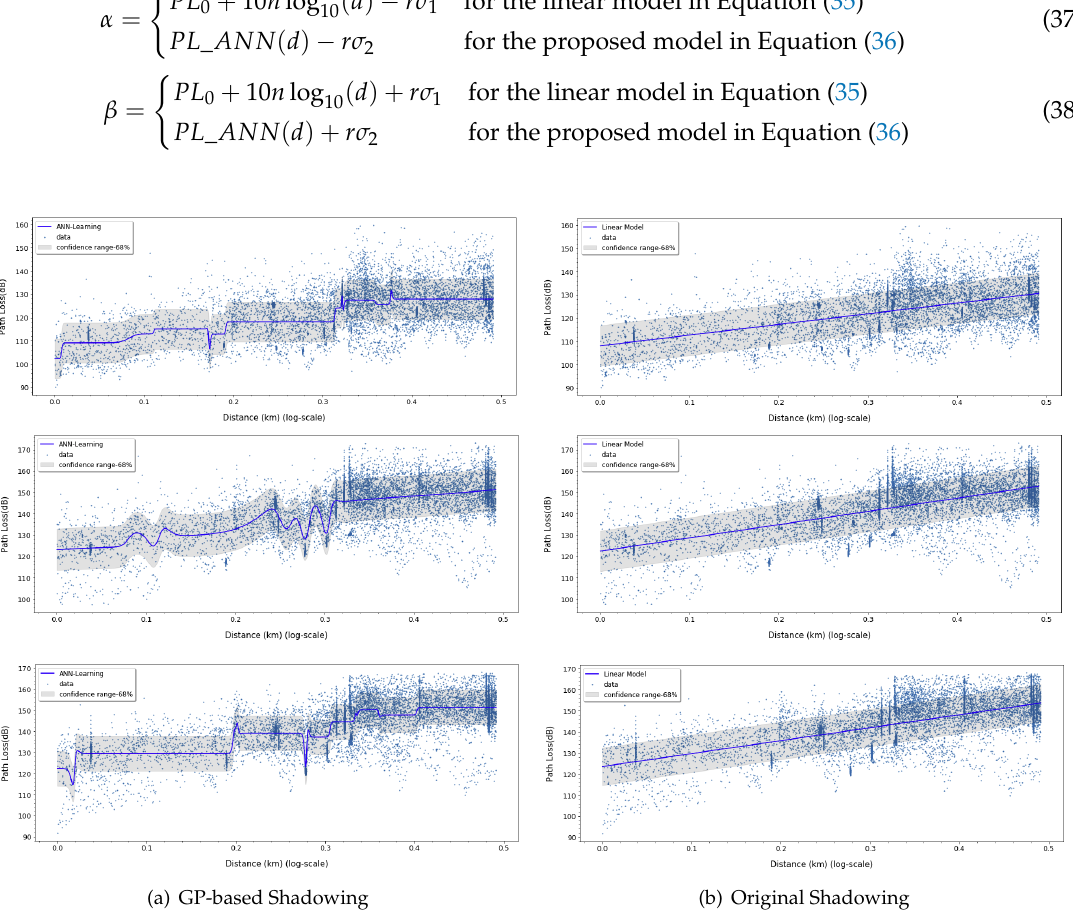
Figure 16. Training graph for the proposed and the linear model with 1 × standard